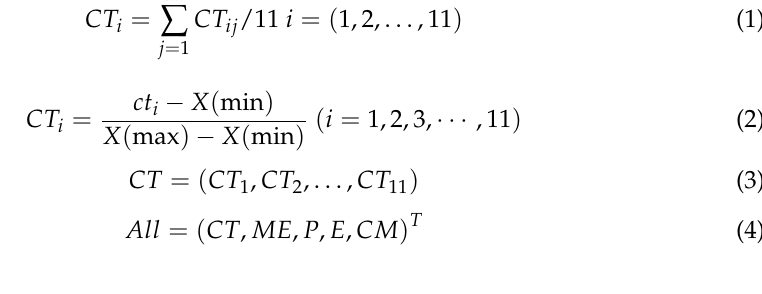
Table 7. Construction safety risk evaluation